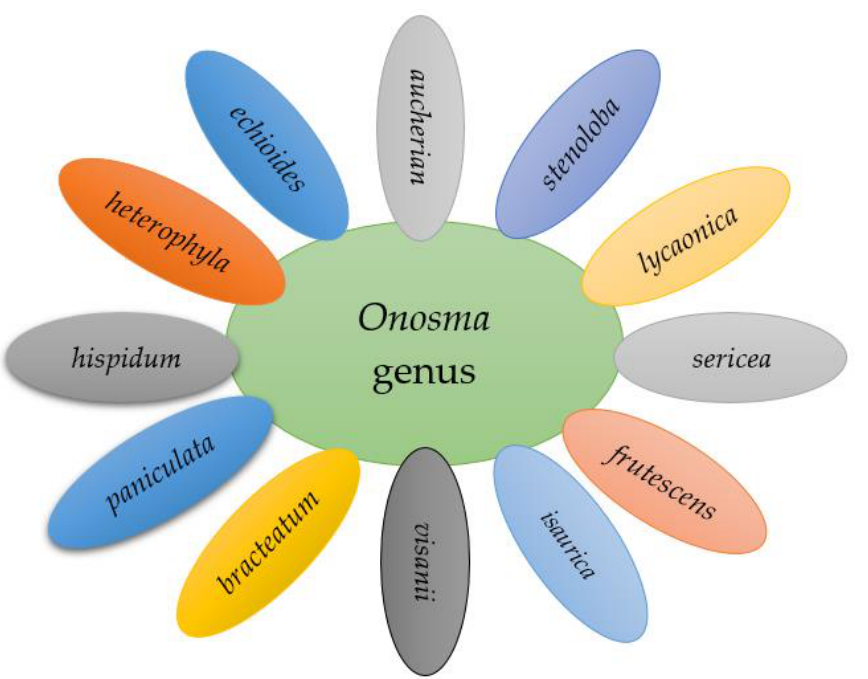
Figure 1. Representative example of the most-studied species of the genus Onosma in terms of pharmacology actions.